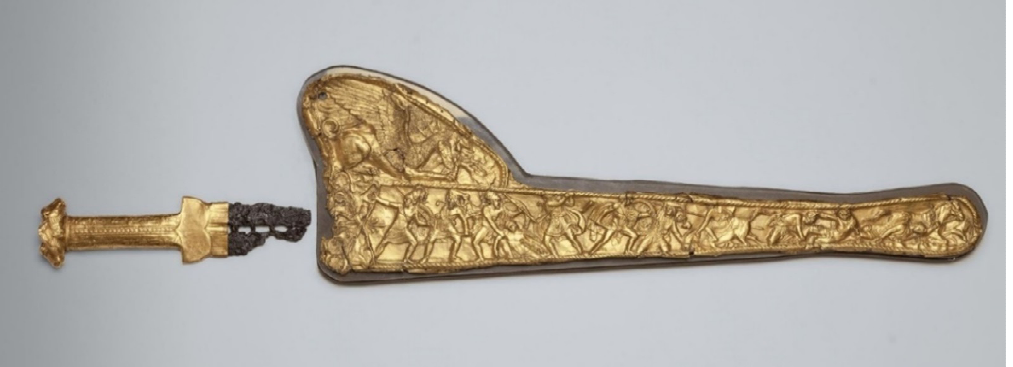
Figure 29. Decorated overlay for a scabbard (not including sword and handle) (SHM inv. no. Дн .1863 ‐ 1/447); gold; Chertomlyk kurgan, Dnepropetrovsk region, Ukraine; 350–325 BC. [Image is used from www.hermitagemuseum.org (accessed 9 November 2022), courtesy of the State Hermitage Museum, St. Petersburg, Russia].